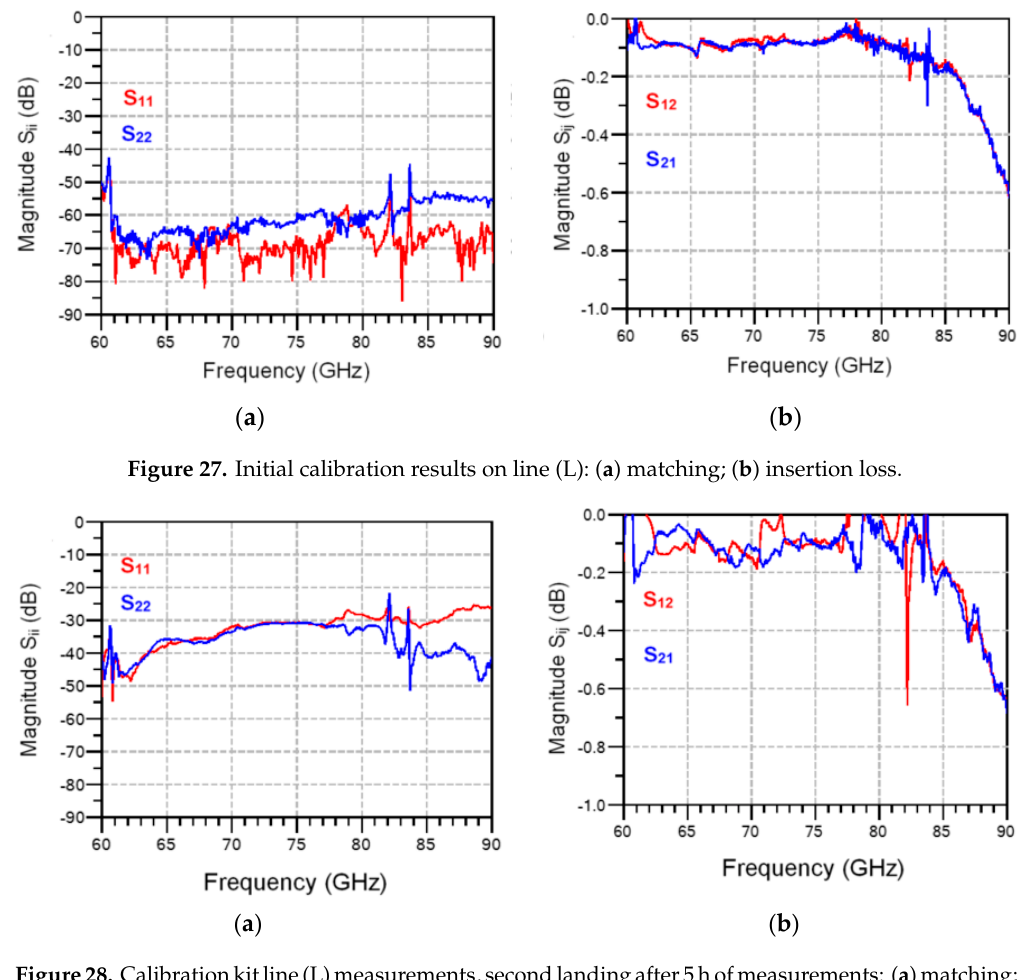
Figure 26. Coplanar and DC probe landings on calibration kit line: ( a ) down; ( b ) up after measurement.